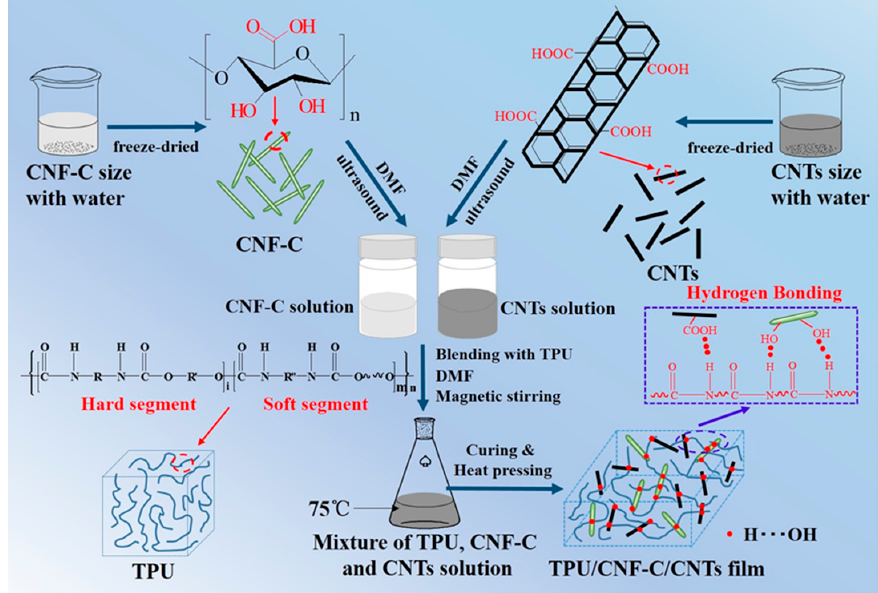
Figure 3. Schematic illustration of the hydrogen bonding interaction mechanism among molecules of TPU, CNF-C, and CNTs, and the film formation of